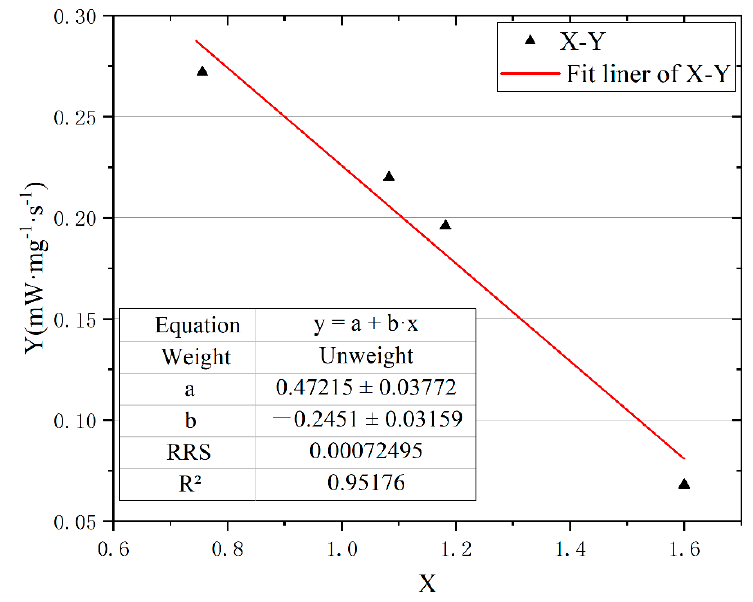
Figure 8. Regression analysis of microstructure parameters and fire hazard.